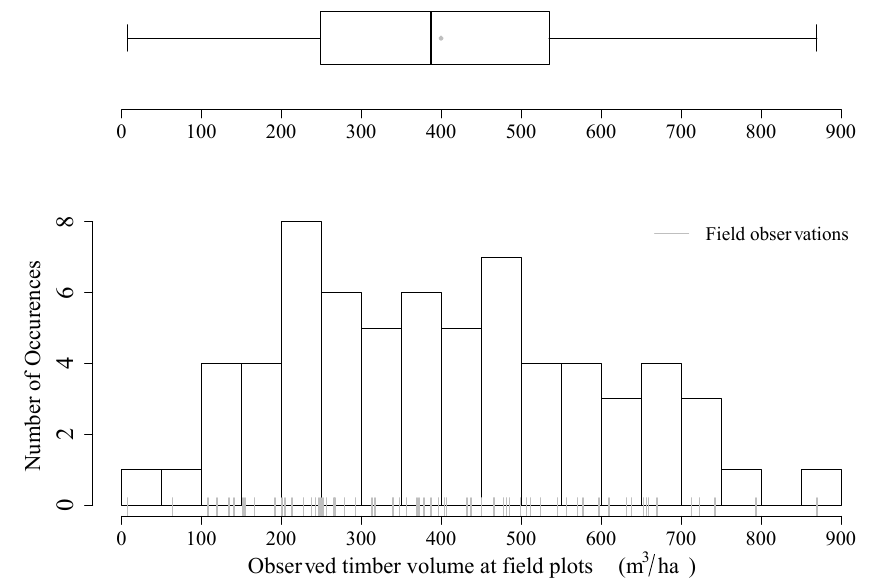
Figure 2. Terrestrial observed timber volume on plot level for all 67 sample plots of the